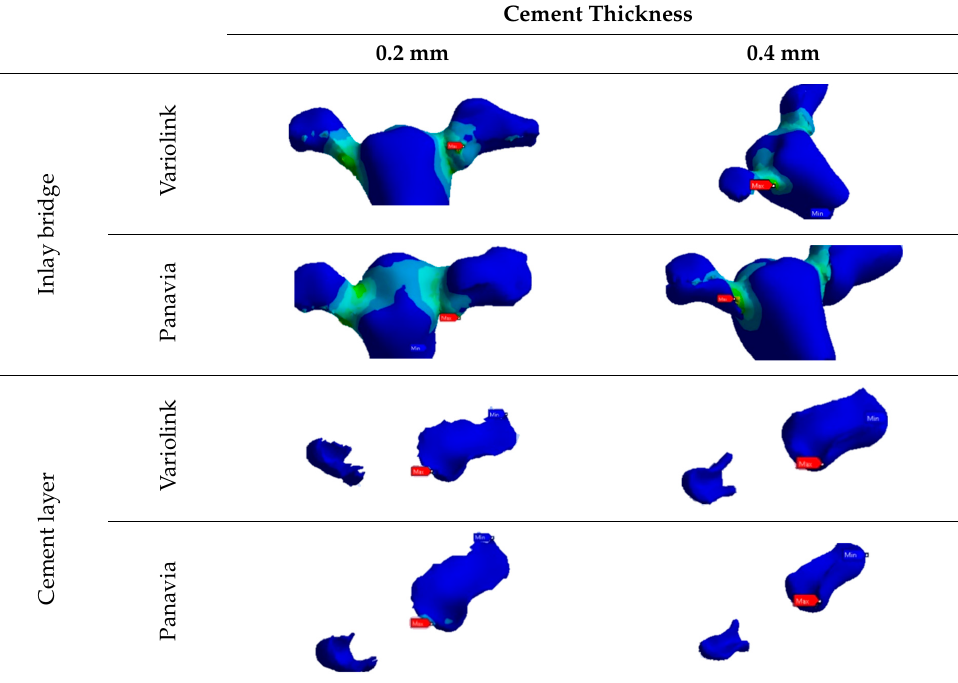
Table 3. Stress distribution on the inlay bridge and the cement layer for both Variolink and Panavia, 0.2 and 0.4 mm.